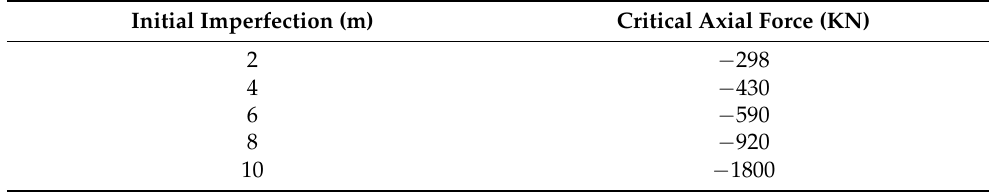
Figure 7. Influence of initial imperfection in the axial force – lateral displacement graph. Table 5. Critical axial force of initial imperfection. Table 5. Critical axial force of initial imperfection.